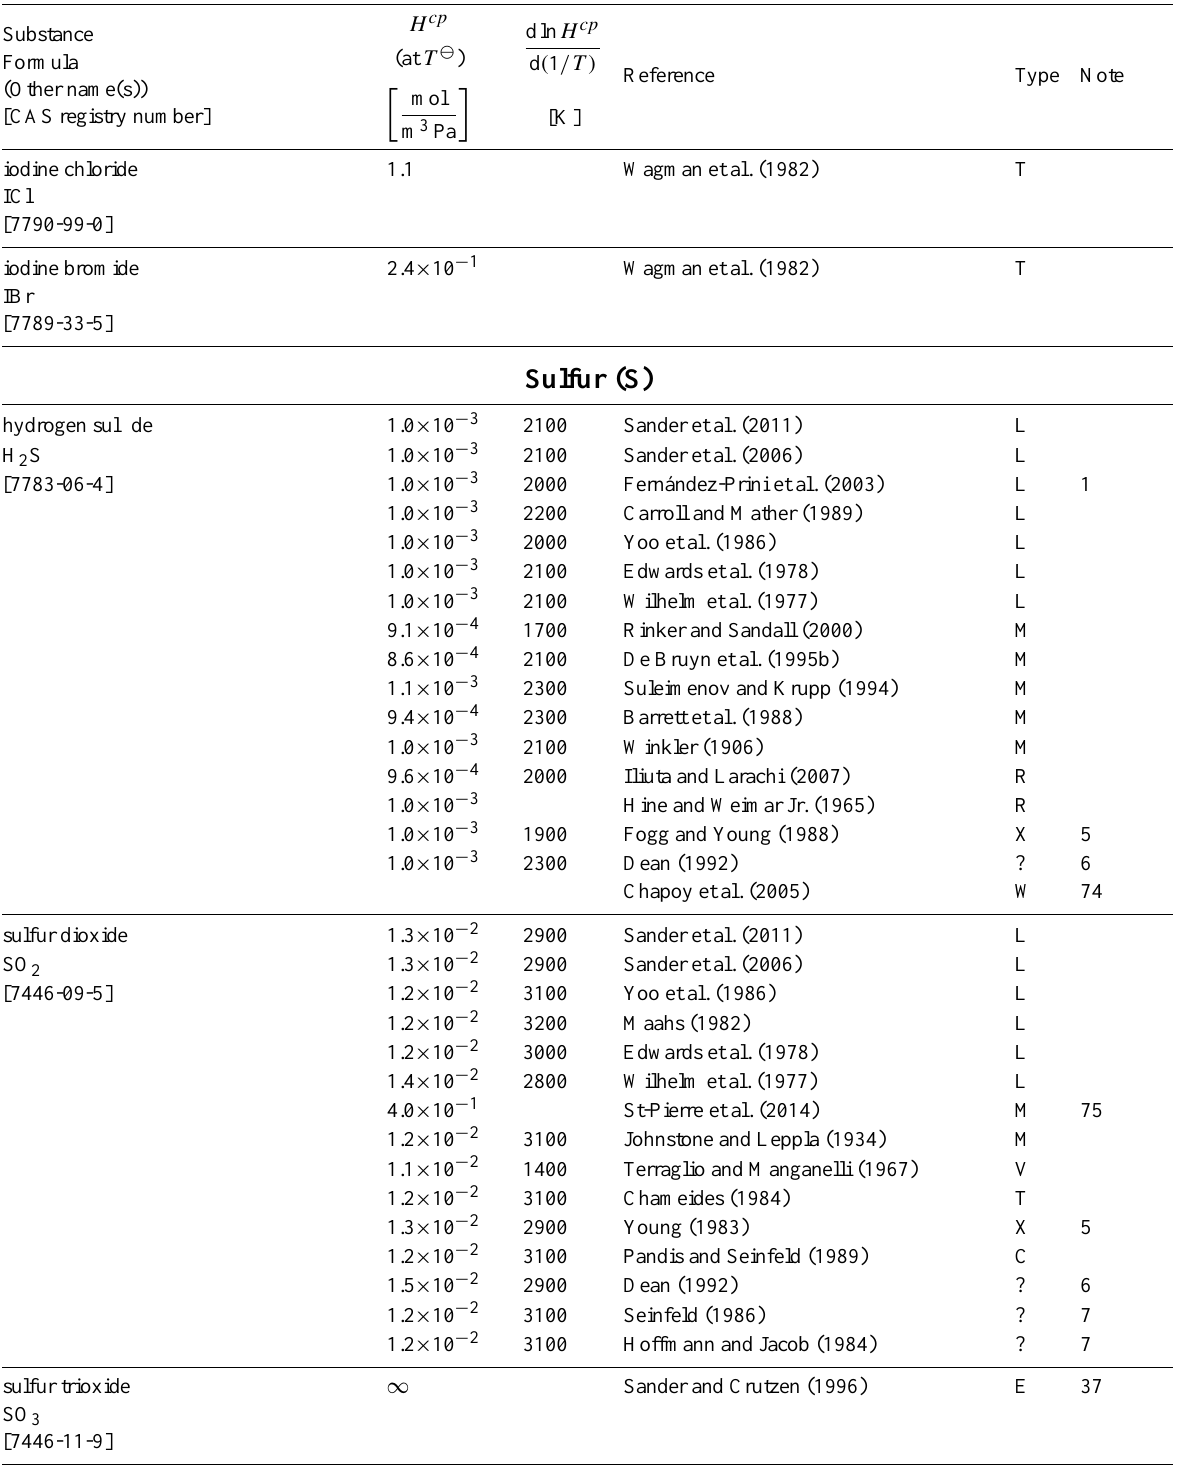
Table 6: Henry’s law constants for water as solvent